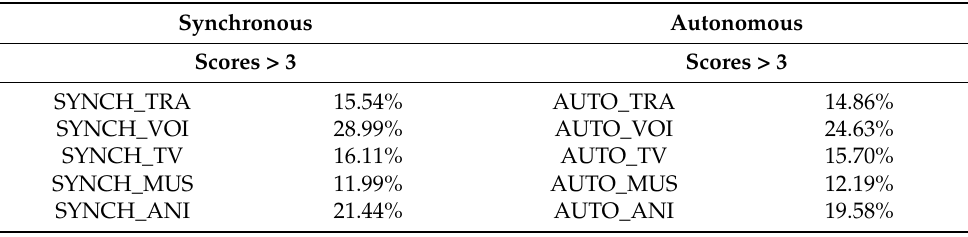
Table 8. Percentage of students who report that noise highly interferes with their engaging in autonomous and synchronous activities (scores of ≥